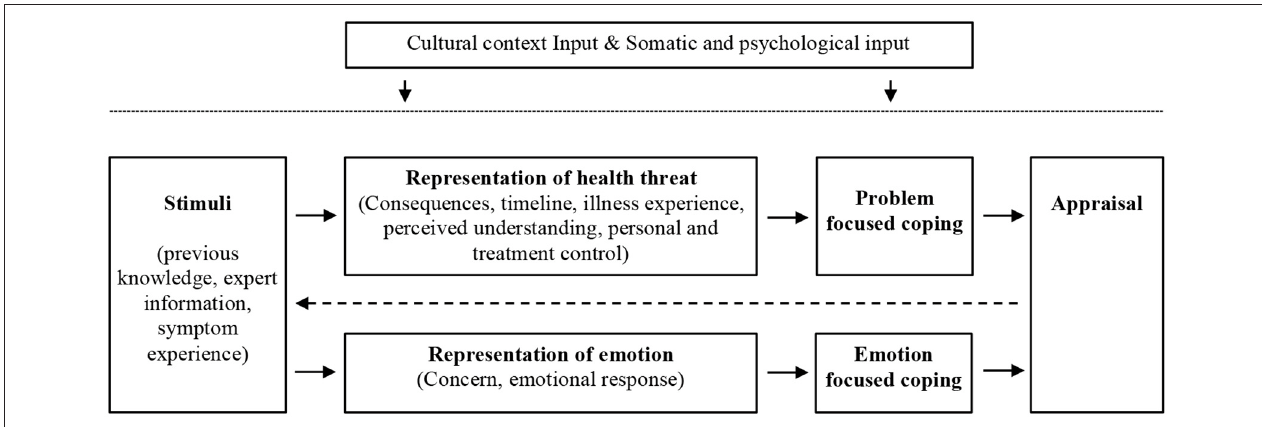
FIGURE 1 | Common-sense model of self-regulation. Adapted from Diefenbach and Leventhal